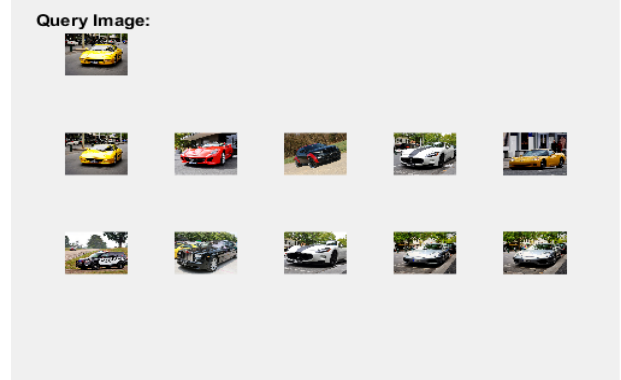
Figure 13. .Accuracy of all datasets